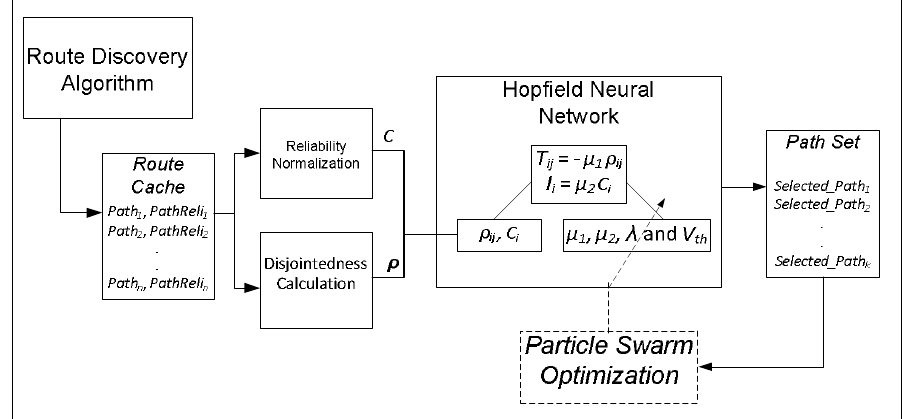
Fig. 3. Conceptual scheme of proposed algorithm